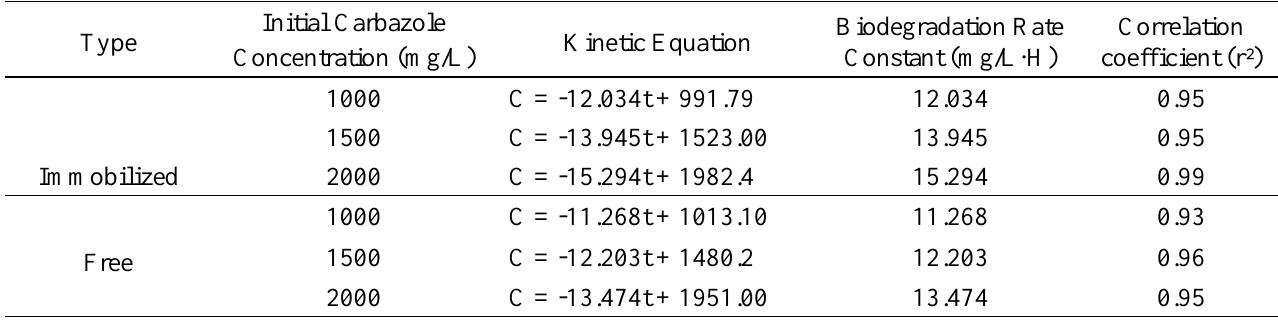
Table 1. Kinetic study of immobilized and free cells on various initial concentration